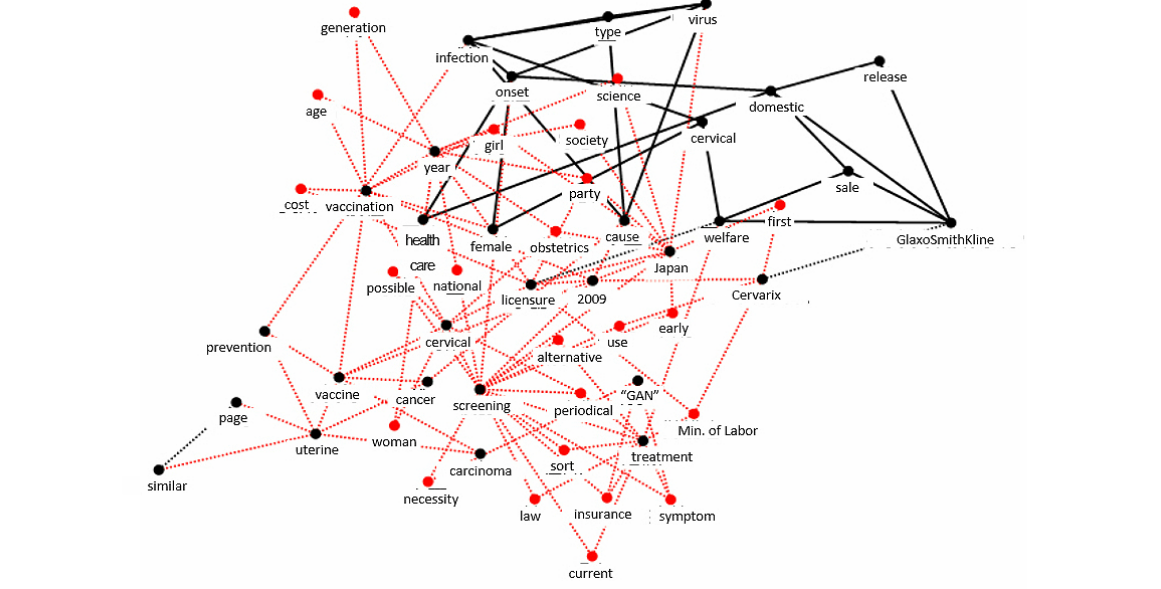
Figure 2. Keyword map (KeyGraph) showing the primary stakeholders in HPV vaccination in 2009. The most frequent words are shown with black nodespairs of these frequent words co-occurring the most get linked via black lines. “GAN” is a Japanese word meaning